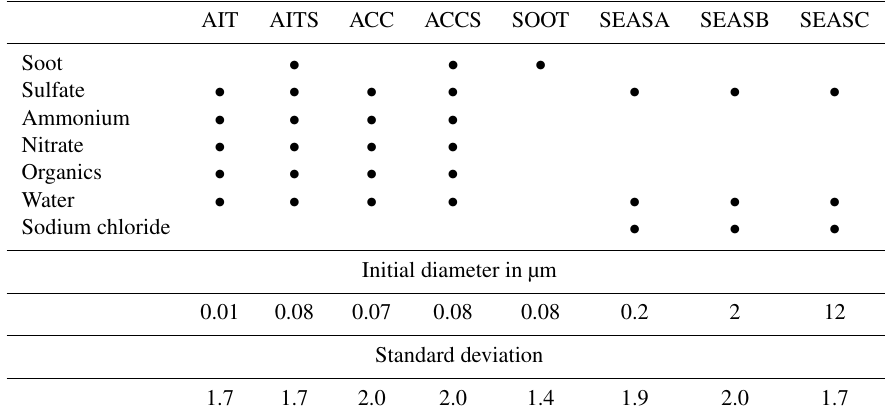
Table 1. Chemical composition, initial number-median diameter, and standard deviation of the lognormal distributions of the eight modes. (AIT: Aitken mode, AITS: Aitken mode containing a soot core, ACC: accumulation mode, ACCS: accumulation mode containing a soot core, SOOT: pure soot mode, SEASA: sea salt fine, SEASB: sea salt medium, SEASC: sea salt coarse). AIT AITS ACC • • • Sulfate • • • • • • • • • • • • • • • Organics • • • • Water • • • • • • •